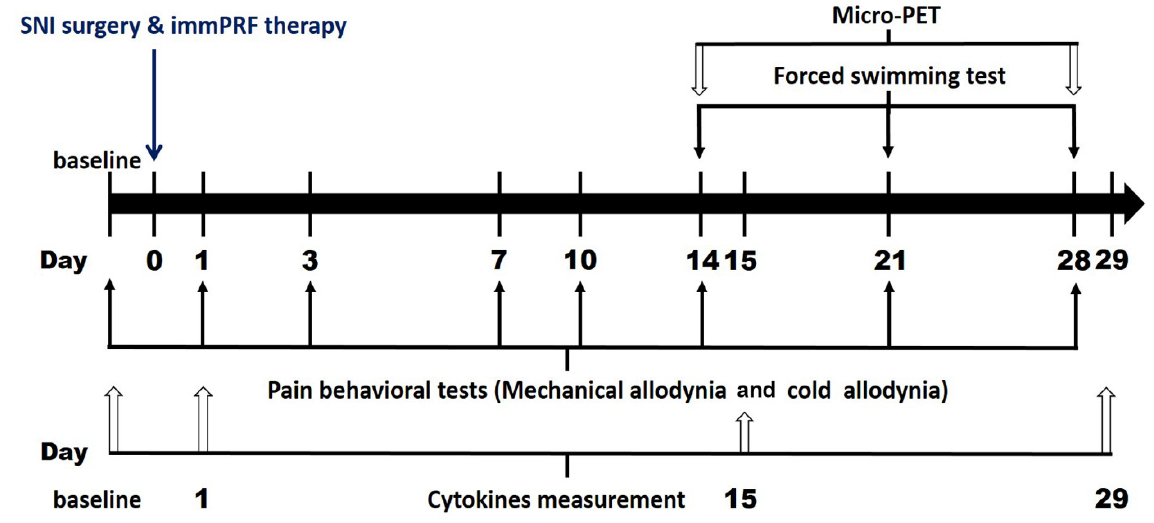
Figure 1. The time chart presents the treatment protocol of animal experiments in this study. During the protocol, SNI surgery and PRF therapy were performed at day 0. The behavioral testing, mechanical allodynia, and cold allodynia examination were performed on day 1, 3, 7, 10, 14, 21, and 28 of the experiment. Additionally, the rats accepted the micro-PET imaging analysis on day 14 and 28, and carried out the forced swimming test on day 14, 21, and 28. In order to avoid animal deaths caused by excessive stress, we drew animal blood for cytokines analysis 1, 15, and 29 days after entering the experiment.